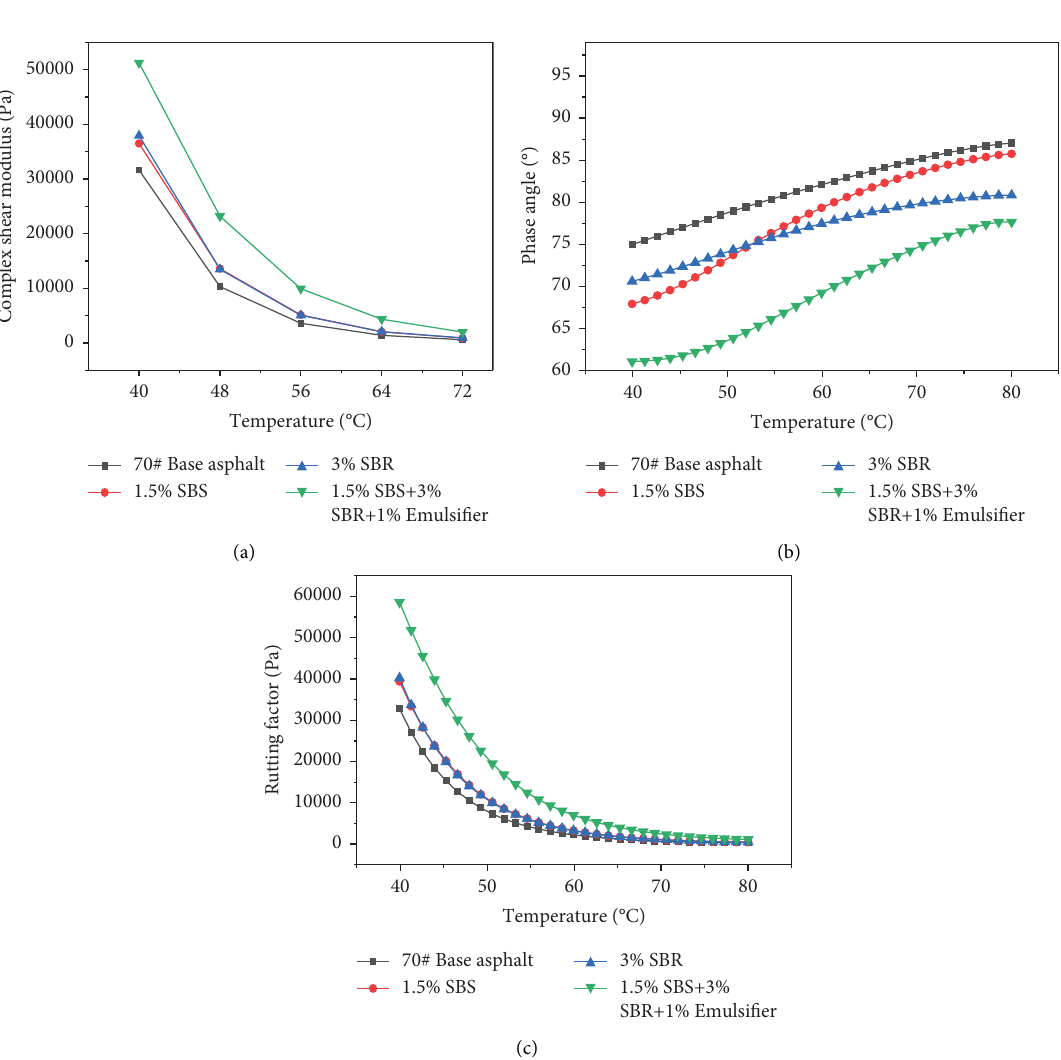
Figure 6: Variation of complex shear modulus and phase angle with shear strain for four types of emulsifed asphalt.